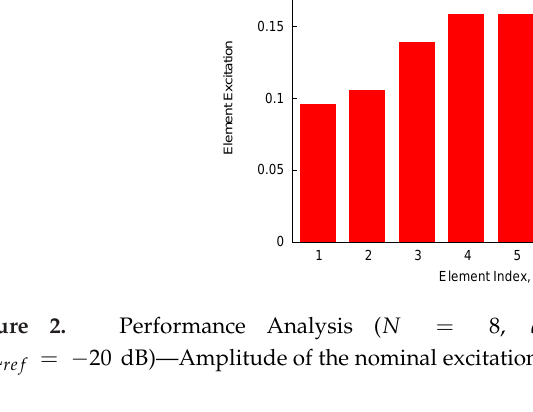
Figure 2. Performance Analysis ( N = 8, d = λ SLL ref = − 20 dB)—Amplitude of the nominal